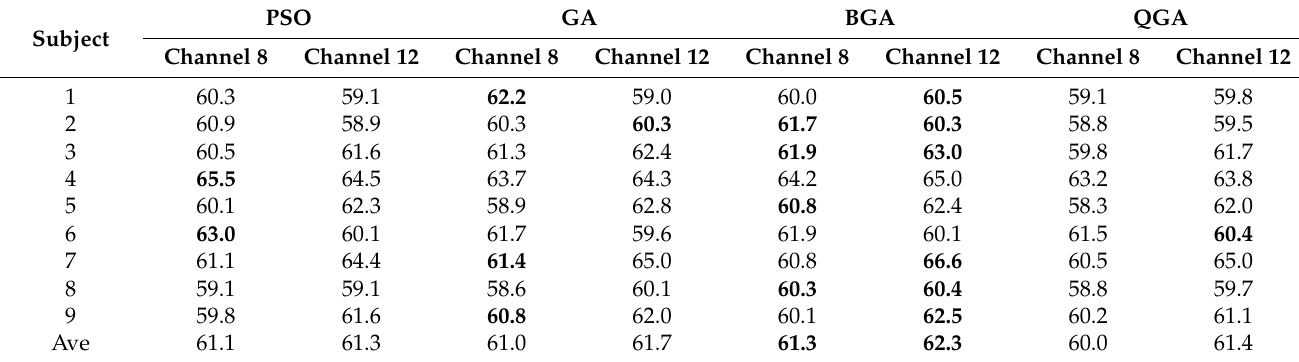
Table 7. Feature selection accuracy of PSO, GA, BGA, and QGA with 100 features, FB2, and ELM for 100 iterations.